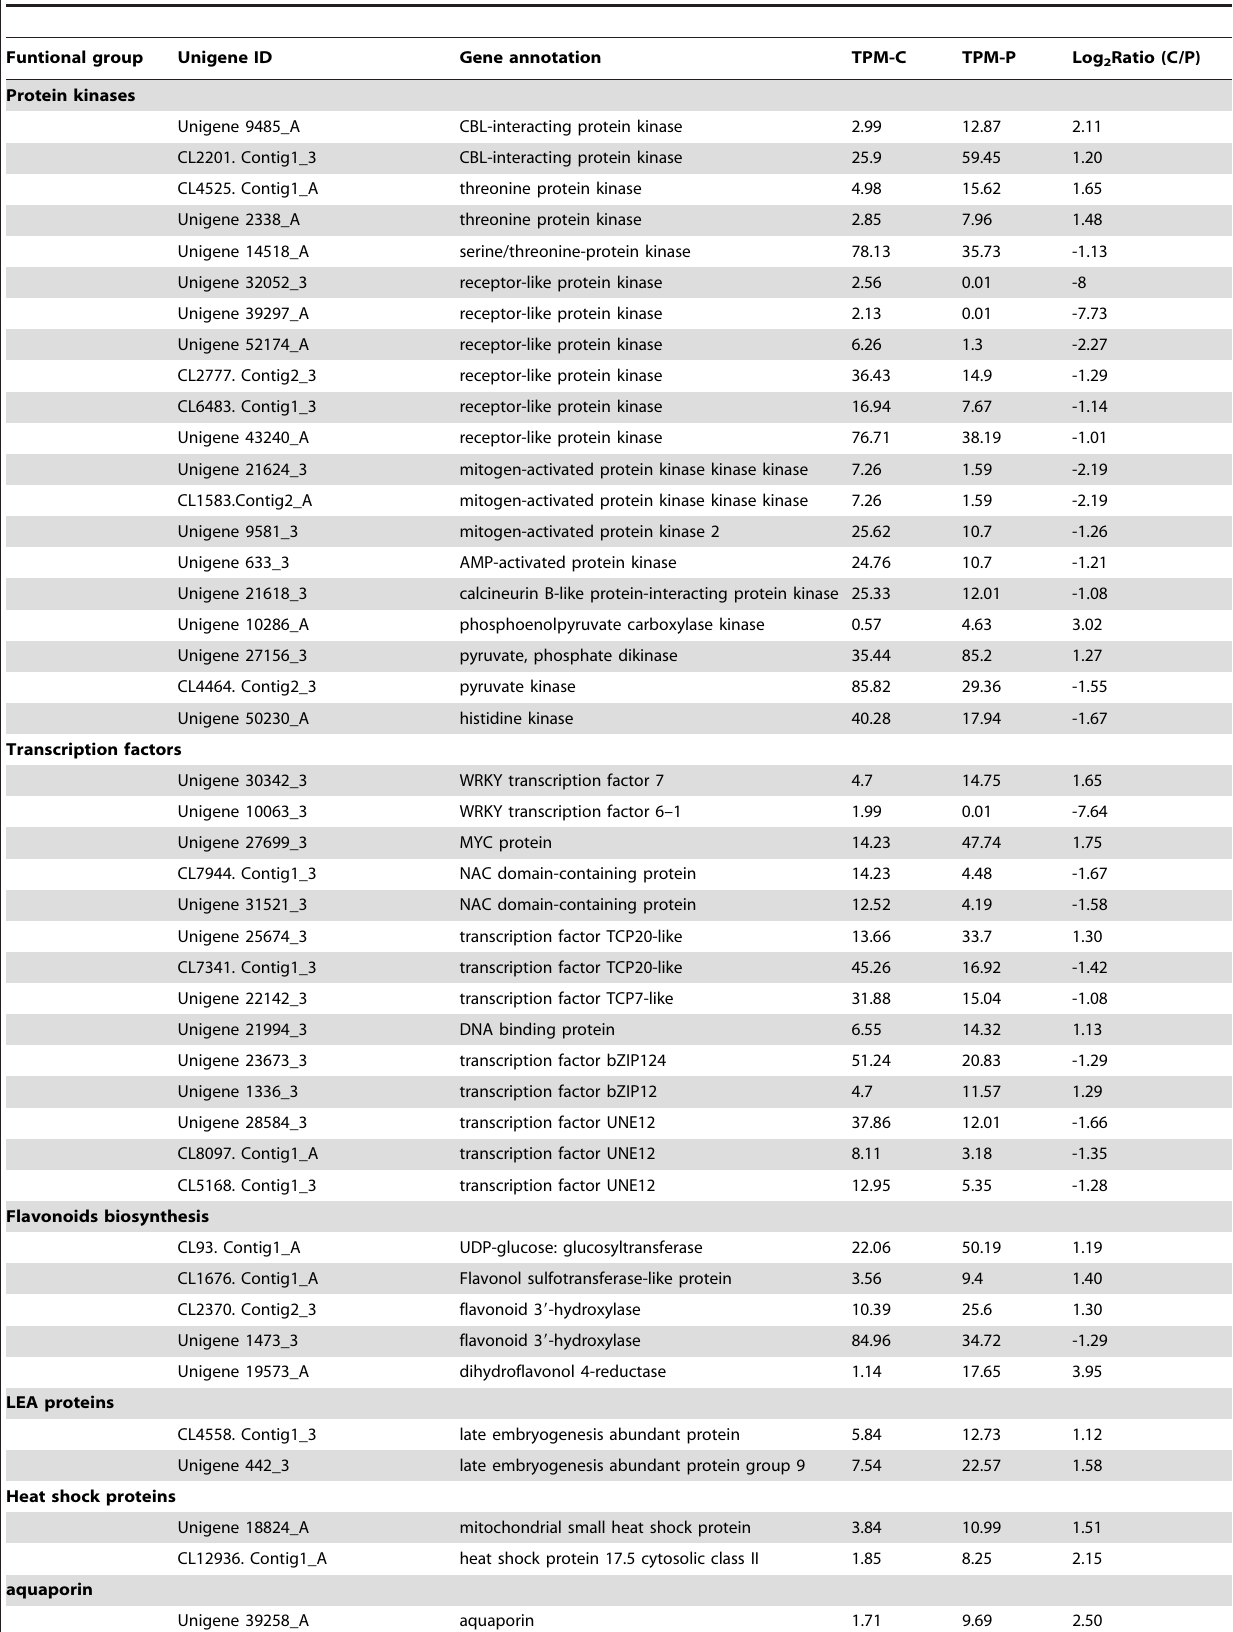
Table 2. Selected DEGs between the C and P libraries.